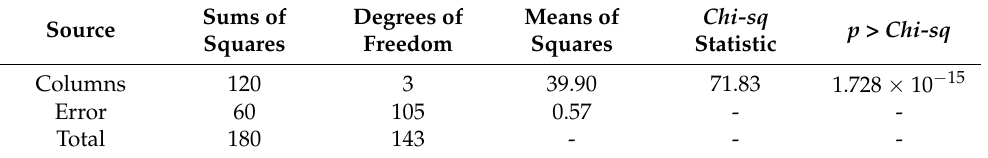
Table 12. Results of Friedman test for oil Midel 1204 with different concentrations of surfactant Triton X.